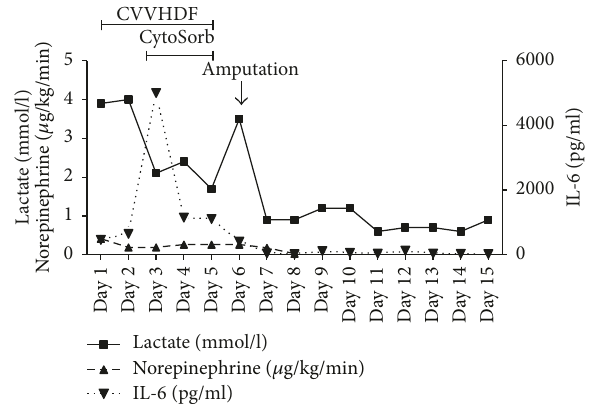
Figure 1: Plasma concentrations of IL-6 and lactate and the need of noradrenalin during the course of the eight treatment sessions. Day 1 represents start of treatment directly after postoperative transfer to